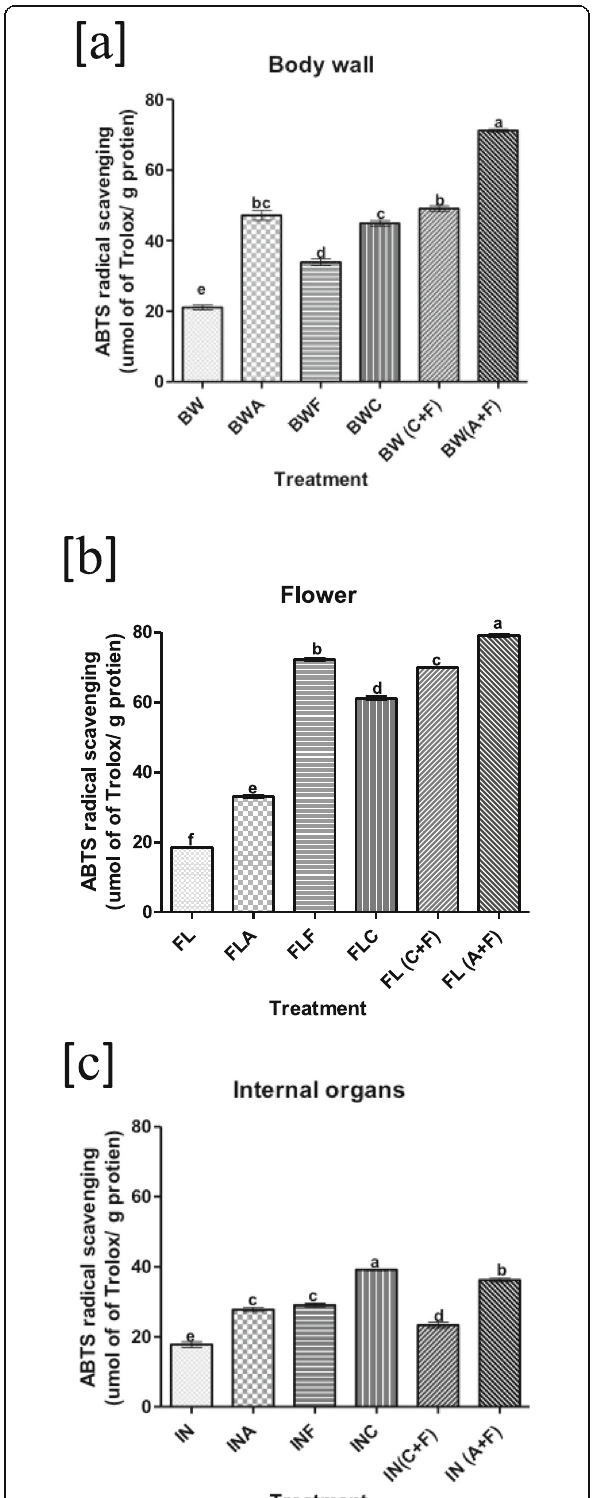
Fig. 5 ABTS radical scavenging activity of sea cucumber C. frondosa protein hydrolysates a BW, Body wall; b FL, Flower; and c IN, Internal organs; A, Alcalase; F, Flavourzyme; C, Corolase; C + F, Mixture of Corolase and Flavourzyme; and A + F, Mixture of Alcalase and Flavourzyme. Different letters for the same concentration of all hydrolysates indicates significant difference at p <